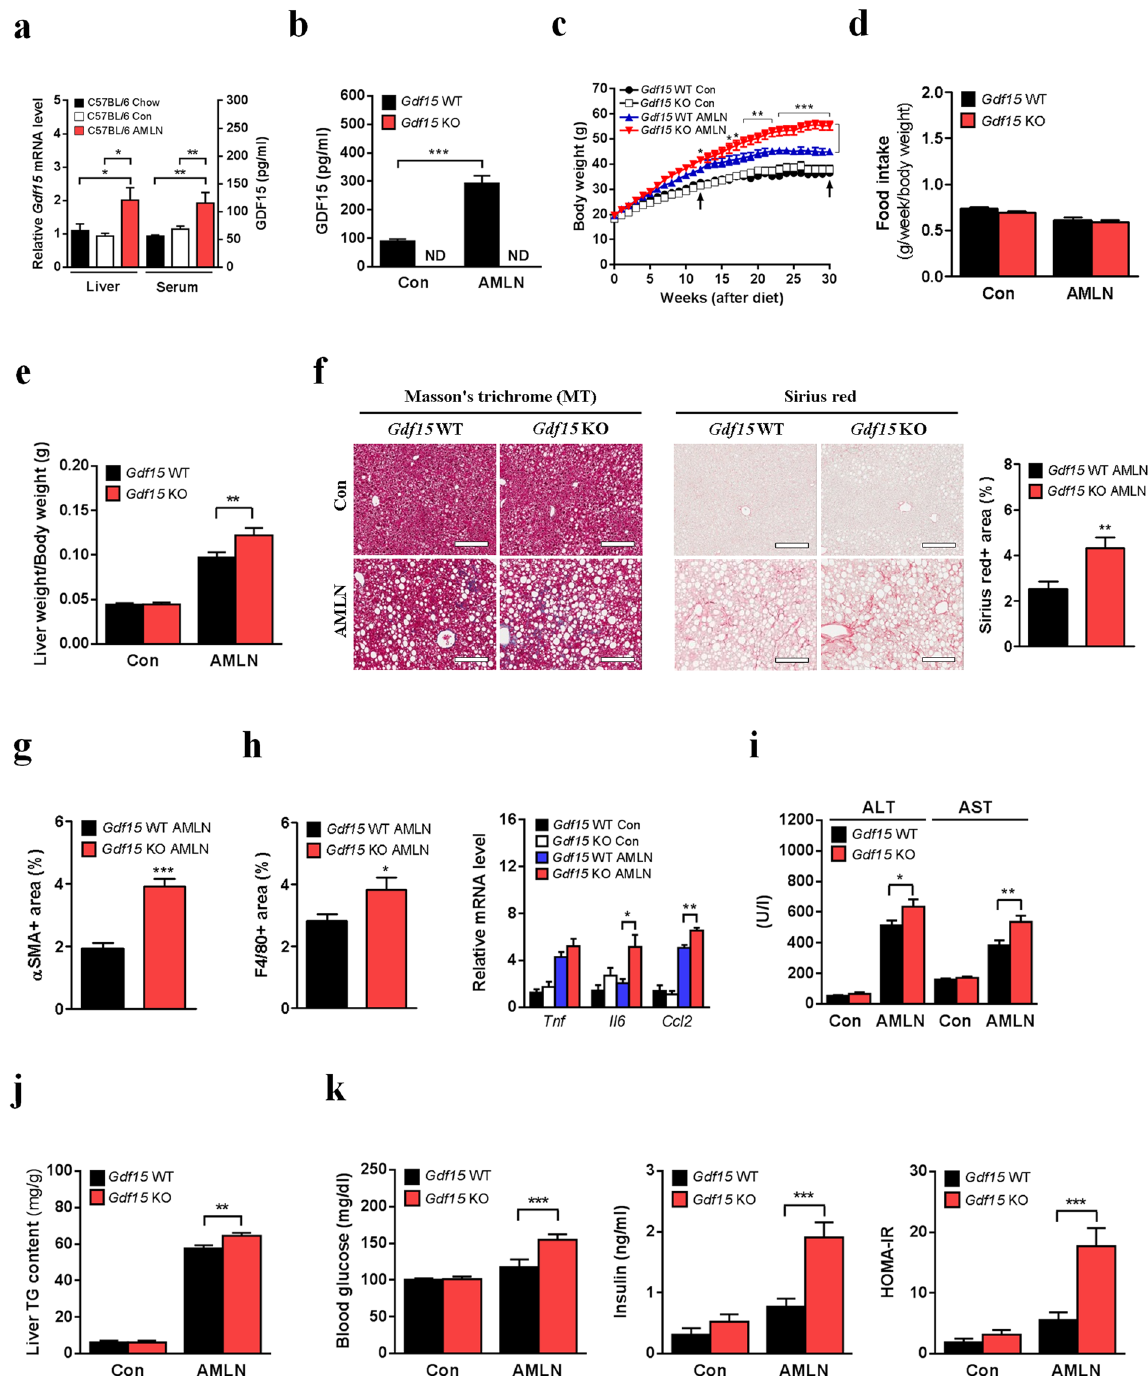
Figure 4. Gdf15 deletion aggravates NASH and related metabolic parameters in AMLN diet-fed mice. ( a ) Relative hepatic Gdf15 mRNA (n = 5–7) and serum GDF15 levels (n = 7) in C57BL/6 mice fed standard chow (Chow), matched control (Con) or AMLN diet (AMLN). ( b – k ) Serum GDF15 level ( b , n = 6–10), body weight ( c , n = 7–16), food intake adjusted for body weight ( d , n = 7–12), liver weight adjusted for body weight ( e , n = 7–12), liver MT staining (left panel of f ), Sirius red staining and quantification (right panel of f ), quantification of α SMA immunochemistry ( g ), quantification of F4/80 immunochemistry (left panel of h ), relative inflammatory gene expression (right panel of h , n = 5–7), serum ALT/AST levels ( i , n = 6–9), liver TG content ( j , n = 6–9), fasting glucose/insulin levels (left and middle panels of k , n = 4–6) and HOMA-IR index (right panel of k , n = 4–6) in Gdf15 –/– and control mice fed AMLN or control diet for 30 weeks. ND indicates not detected. Arrows indicate the time of body weight measurement at 12 weeks and 30 weeks of AMLN diet feeding. Scale bars for MT and Sirius red staining, 200 μ m. Data are means ± SEM. * p < 0.05, ** p < 0.01, *** p <